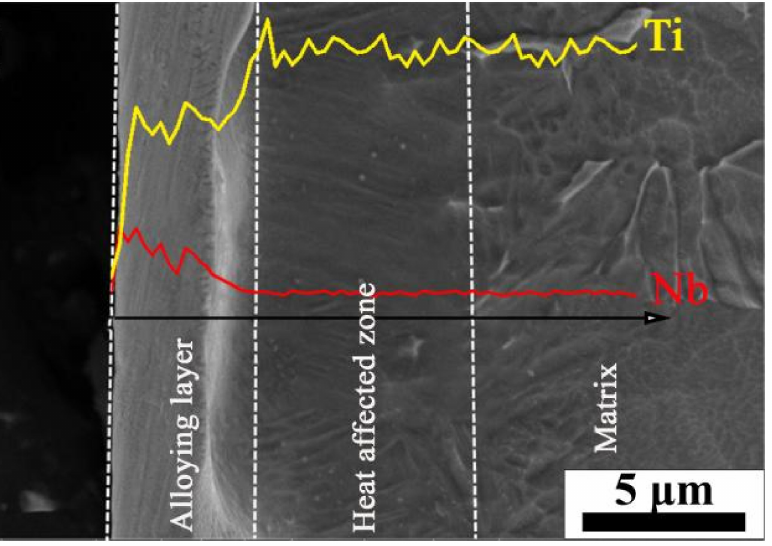
Figure 3. Cross-sectional morphology and EDS analysis of the TC4-Nb samples after 40-pulsed HCPEB